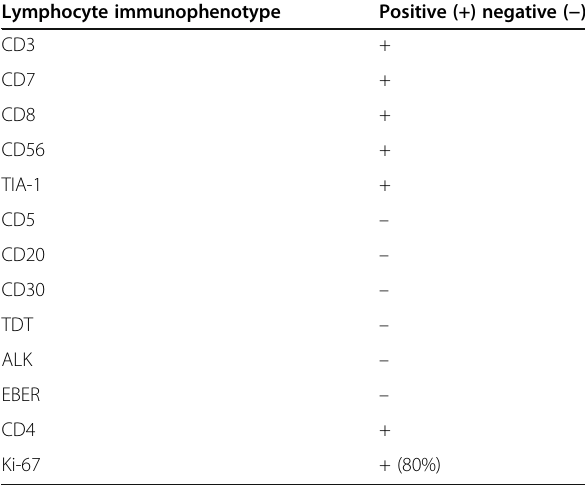
Table 1 Lymphocyte immunophenotype Lymphocyte immunophenotype